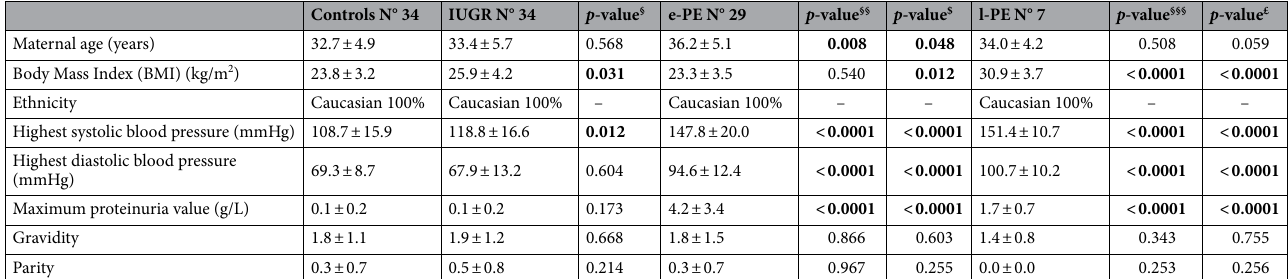
Table 1. Maternal findings of the studied pregnancies. § Two-independent sample t -test (IUGR vs. Controls). §§ Two-independent sample t -test (e-PE vs. Controls). $ Two-independent sample t -test (IUGR vs. e-PE). §§§ Two-independent sample t -test (l-PE vs. Controls). £ Anova Test among the four groups (Controls vs. IUGR vs. e-PE vs. l-PE). IUGR Intrauterine Growth Restriction; PE Preeclampsia; e-PE Early-onset PE; l-PE Late- onset